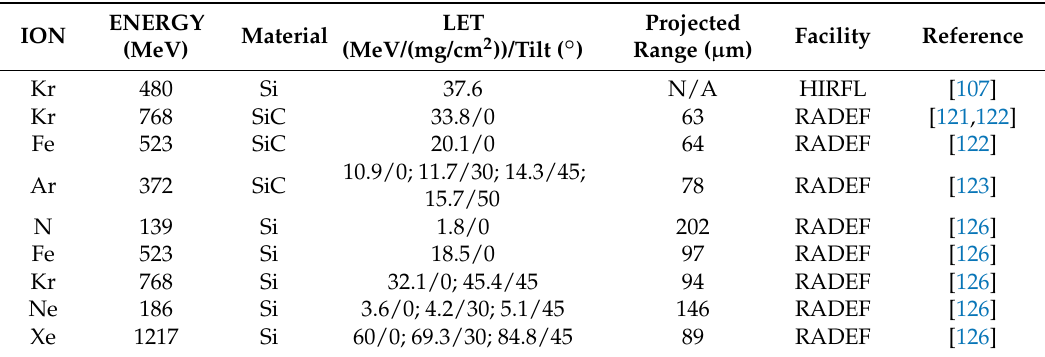
Table 6. Characteristics of the used ion